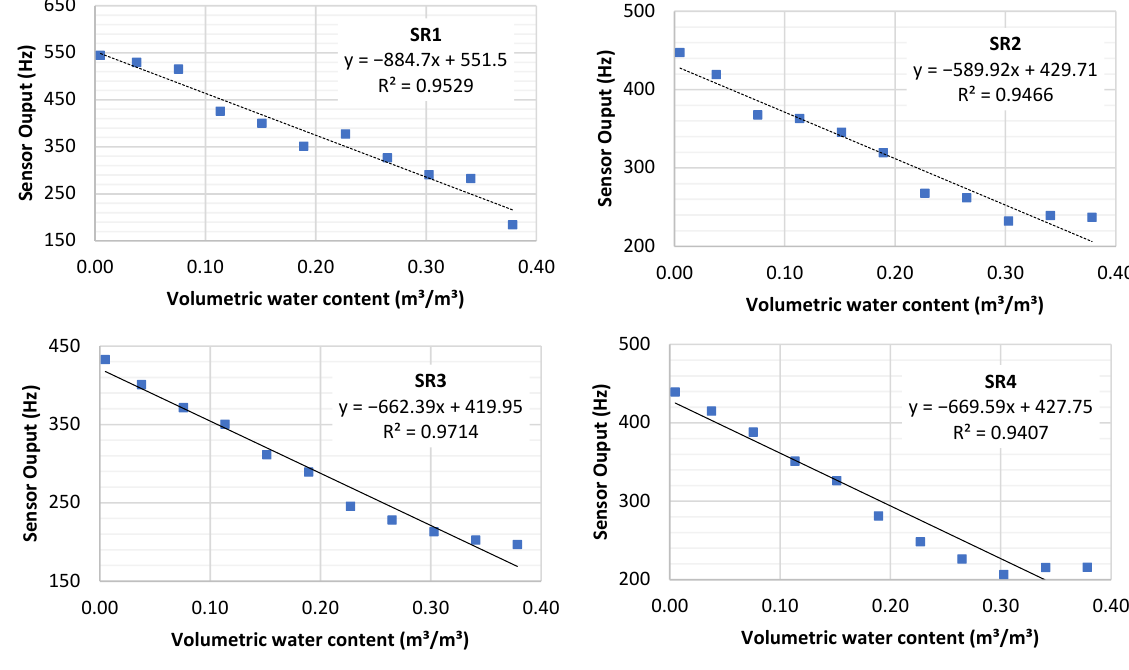
Figure 7. Individual sensor calibration curves used in field testing.